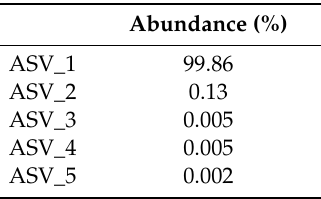
Table 4. Amplicon sequence variants (ASVs) matrix count (%) determined with purR gene